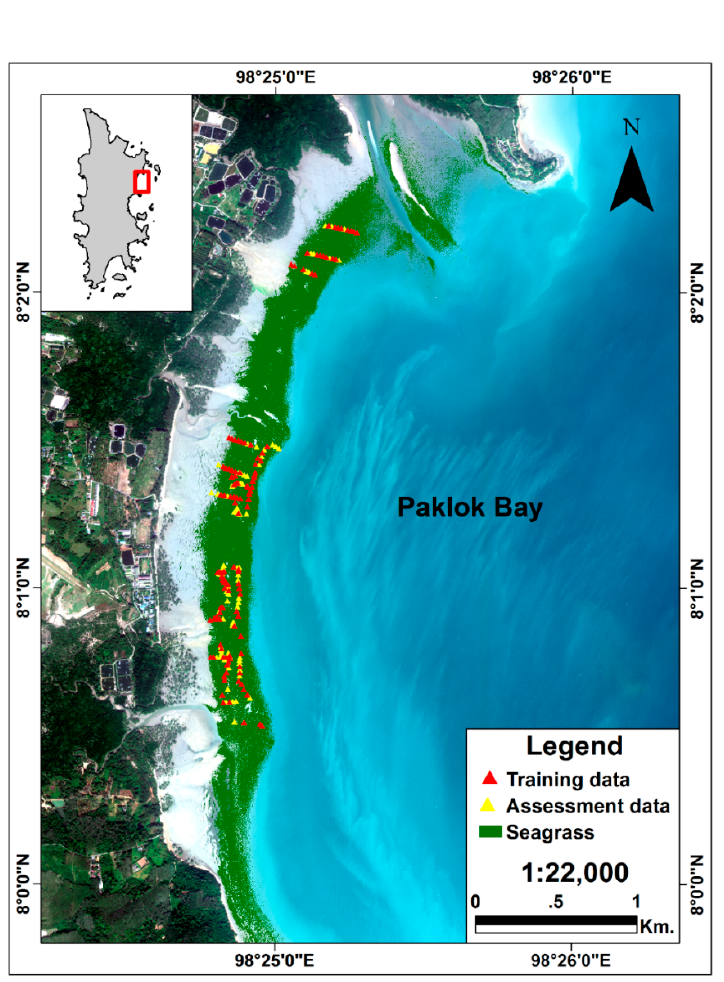
Figure 2. The seagrass area map for Paklok Bay derived from Worldview-2 image.